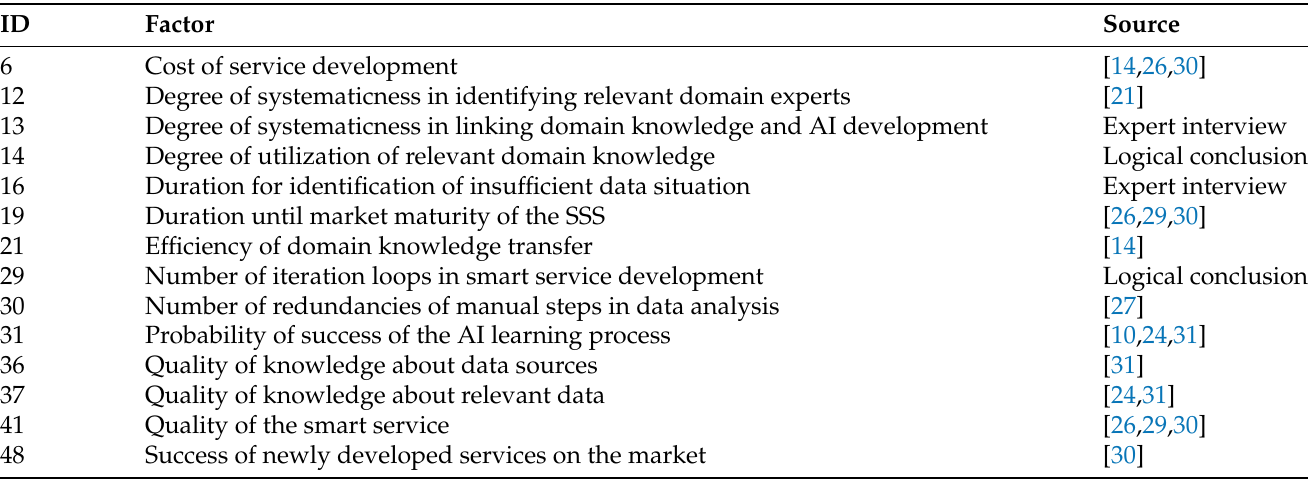
Table A3. Identified success criteria for smart service data specification.